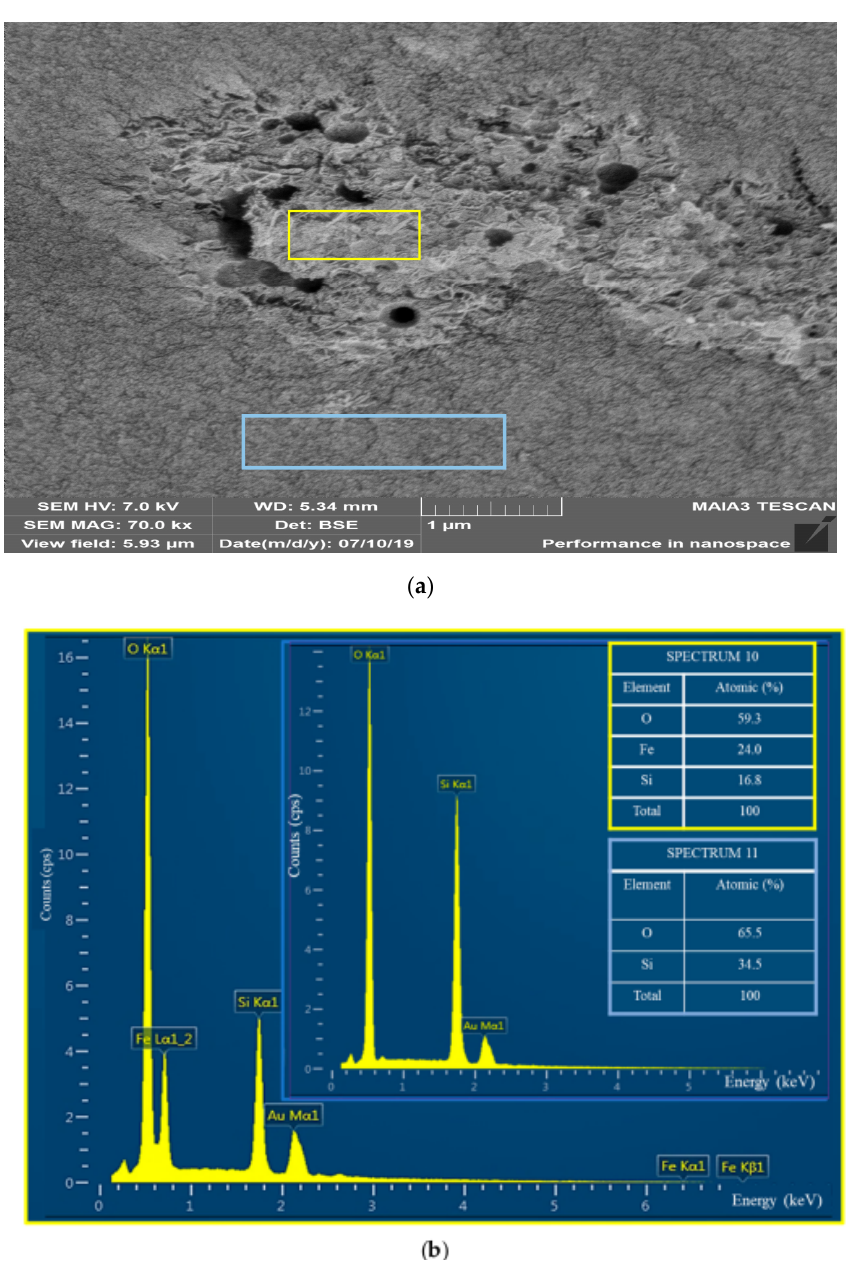
Figure 4. Scanning electron microscopy image and elemental composition of ZVI@ORMOSIL catalyst matrix. ( a ) SEM image of 1.0% ZVI@ORMOSIL matrix. ( b ) Elemental composition measured by electron dispersive analysis in two areas marked in ( a ); Spectrum 10, measured near cracks and breaks in the matrix-yellow frame; Spectrum 11, measured in the monolith bulk of ZVI@ORMOSIL matrix-blue